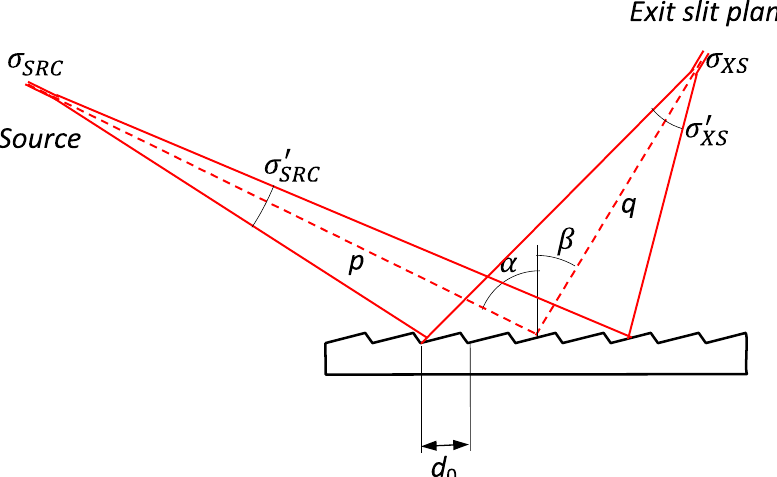
Figure 1. Optical scheme and convention used in this paper to calculate the pulse stretching and the grating’s equation. α and β are positive when on opposite sides of the grating normal and d 0 represents the groove spacing. The distance from the source ( σ XS ) to the grating is called p , and from the grating to the image ( σ (cid:48) ) is called q . The divergences at the source ( σ (cid:48) ) and at the image ( σ (cid:48) ) XS SRC XS are also